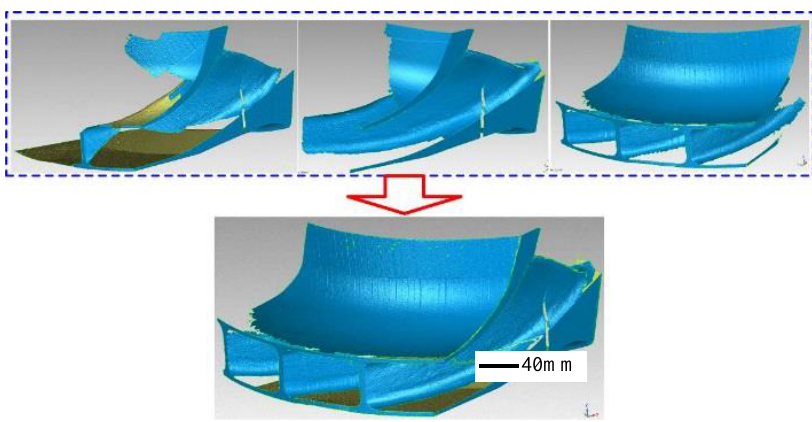
Figure 7. Morphology of blades with preset damage.